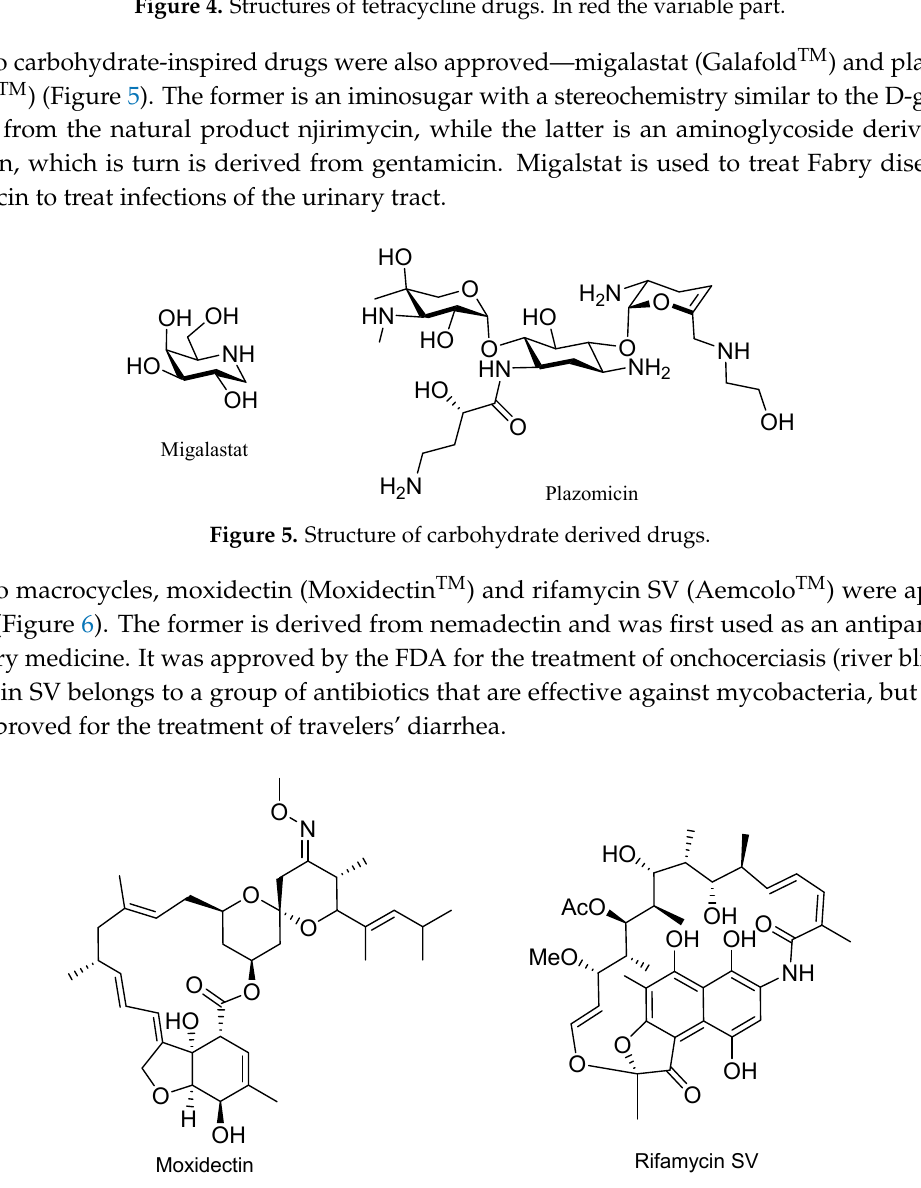
Figure 6. Structure of drugs containing a macrocycle.